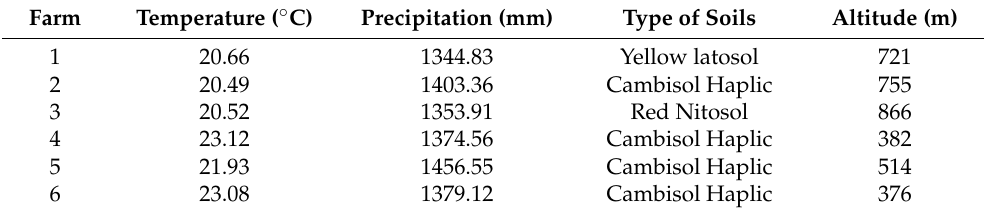
Table 1. Edaphoclimatic characterization of Conilon properties under study.